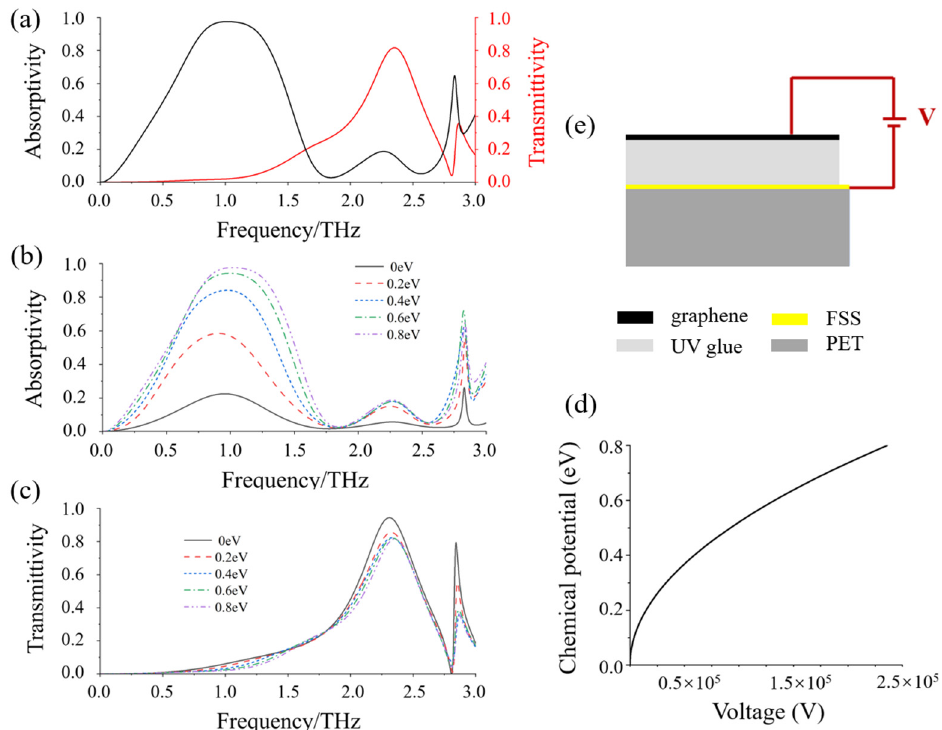
Figure 4. ( a ) The absorption and transmission spectra when the chemical potential is 0.8 ev; ( b ) The absorptivity curves at various graphene chemical potential; ( c ) The transmittance curves at various chemical potential; ( d ) The relationship between the applied voltage and the graphene chemical potential; ( e ) Schematic of how the external voltage is applied to the graphene metamaterial.